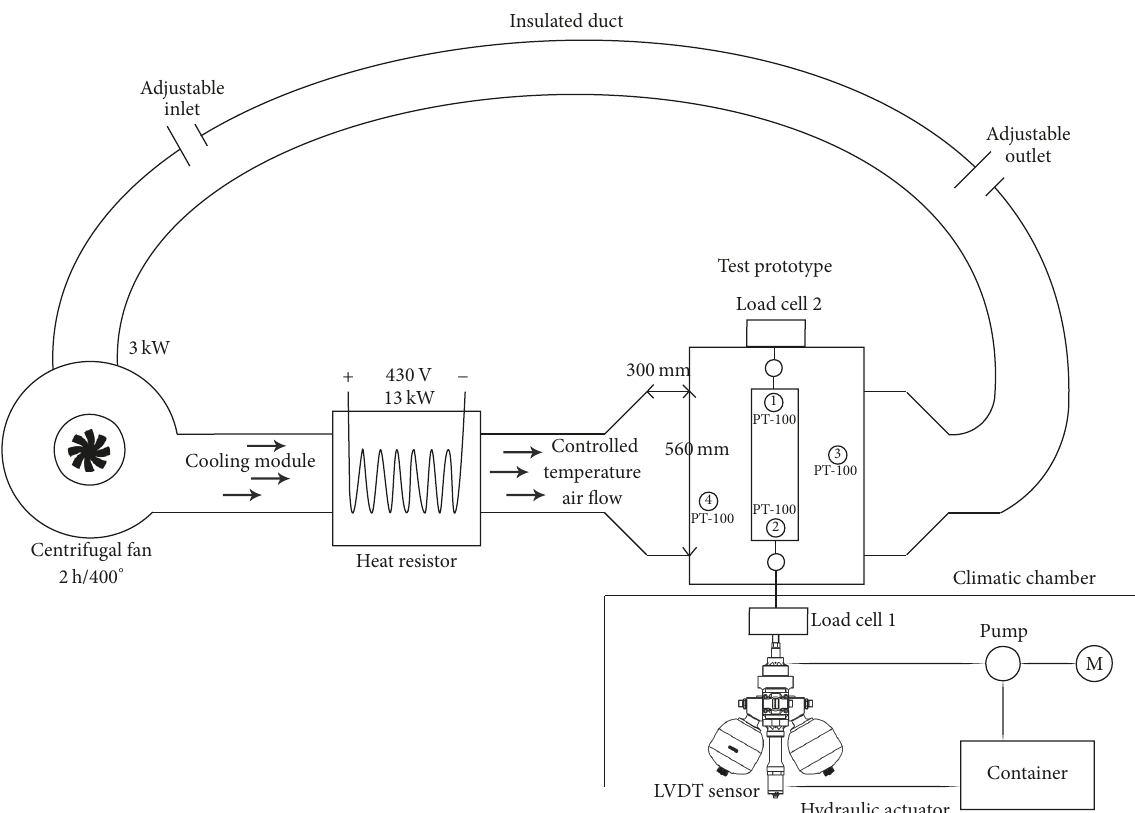
Figure 7: Main test bench components scheme.